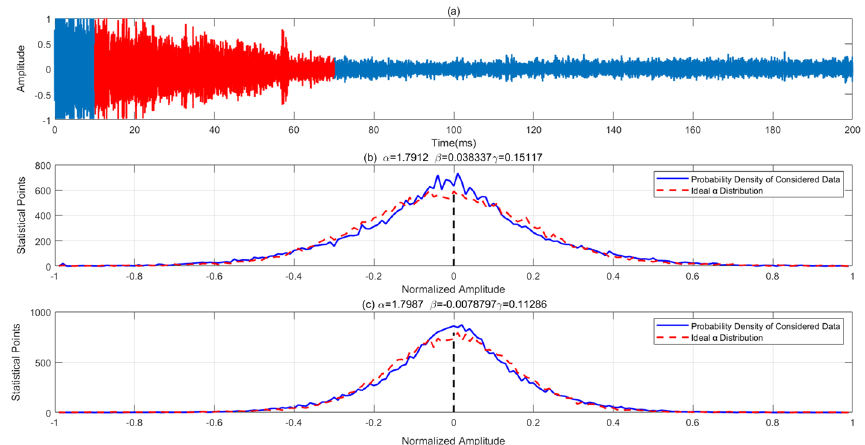
Fig. 9 Probability density curves of time-domain waveform and fractional domain with the optimal transform angle